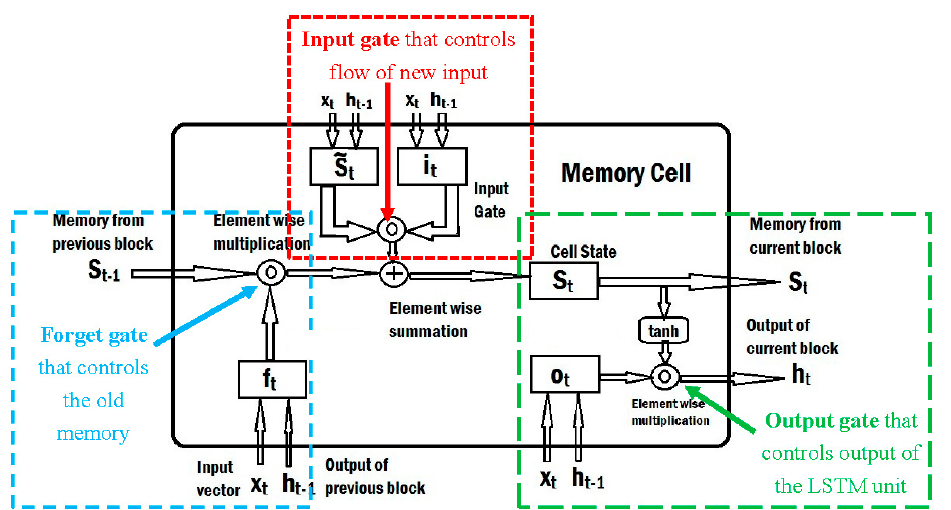
Figure 4. Diagram of a Long Short-Term Memory (LSTM) unit [45].